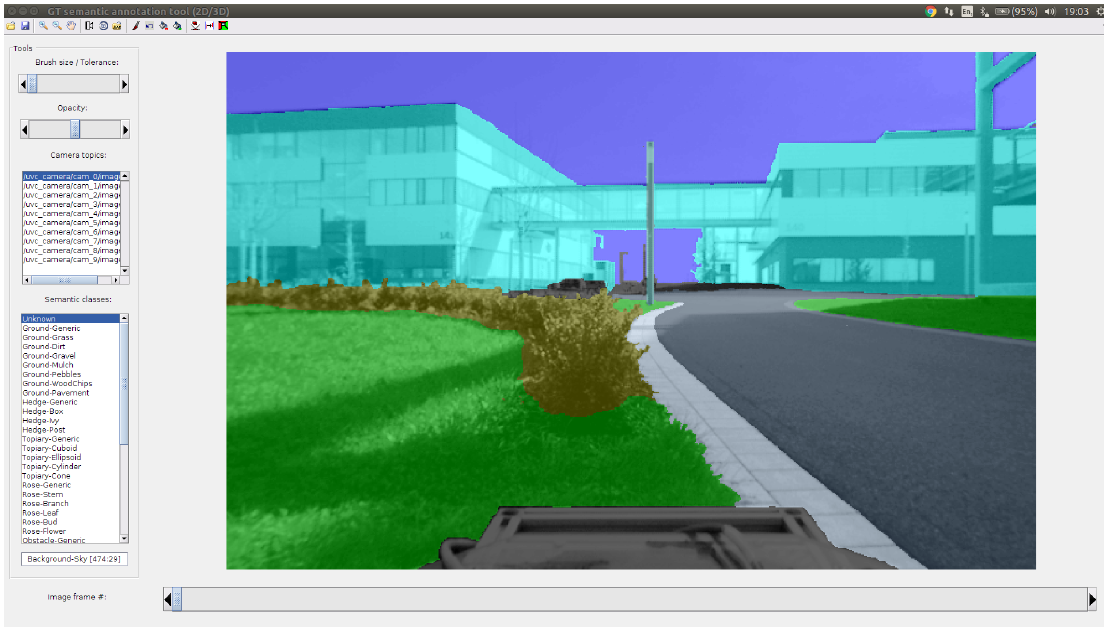
Figure 8. User interface of the developed 2D Image Annotation Tool. The image shows transparent semantic class labels overlaying the original image.